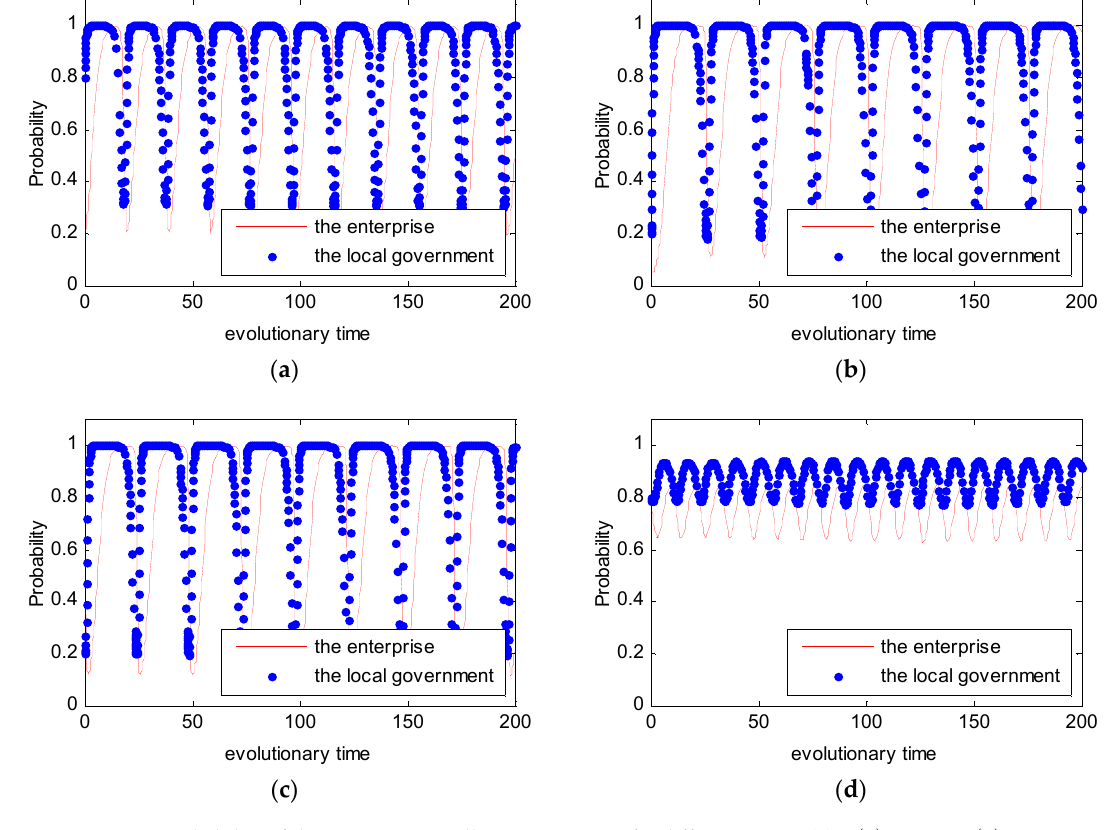
Figure 5. Probability of choosing strong willingness strategy for different time t. ( a ) p t ( 0 ) = 0.2, q t ( 0 ) = 0.8; ( b ) p t ( 0 ) = 0.2, q t ( 0 ) = 0.2; ( c ) p t ( 0 ) = 0.8, q t ( 0 ) = 0.2; and ( d ) p t ( 0 ) = 0.8, q t ( 0 ) = 0.8.